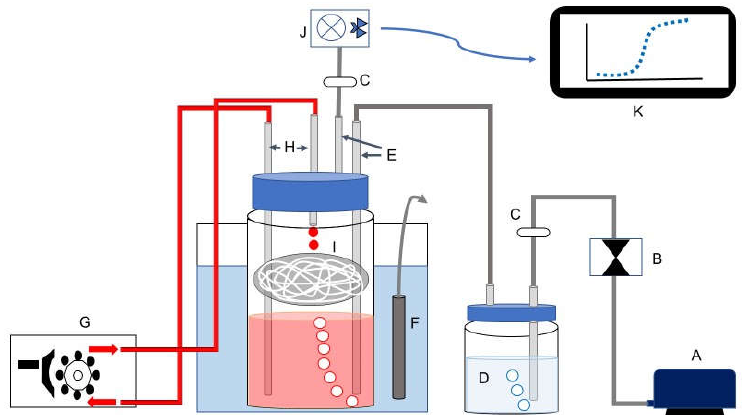
Figure 1. Scheme of biofilm bioreactor designed: (A) air pump; (B) air flow control; (C) air filter; (D) external bubbler; (E) air inlet and outlet; (F) thermostat; (G) peristaltic pump; (H) culture medium inlet and outlet; (I) inert support (metal structure packing); (J) wireless CO 2 sensor; (K) LabQuest interface for data recovery. The samples were taken at the culture media inlet port.